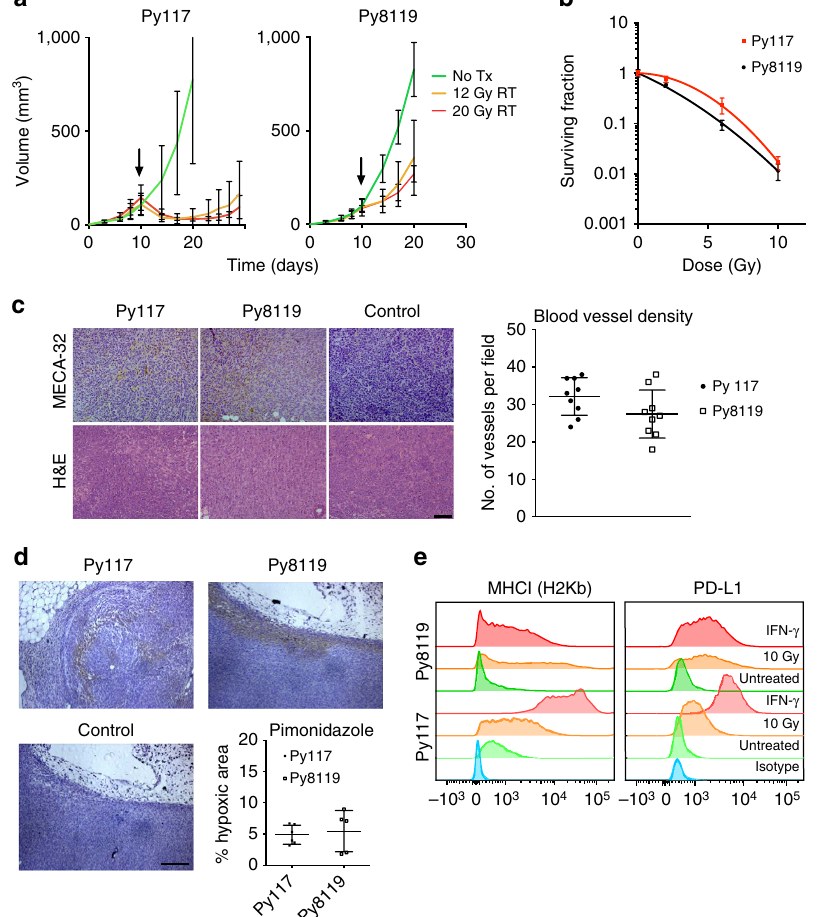
Figure 1 | PyMT syngeneic tumours have different radiosensitivity that is not due to classic factors. ( a ) Orthotopic implantation reveals that Py117 tumours are more radiosensitive than Py8119 tumours and when untreated tumours have a similar growth rate ( n ¼ 4–5 each group). ( b ) Clonogenic survival to evaluate intrinsic factors of radioresistance in culture showed no significant differences between the two tumour clones. ( c ) Blood vessel density was determined with MECA-32 staining showing no significant difference between two tumours (three mice, three fields per tumour; scale bar, 100 m m). ( d ) Levels of hypoxia are similar on the day radiation would be given as determined by pimonidazole immunohistochemistry (5–6 mice each; scale